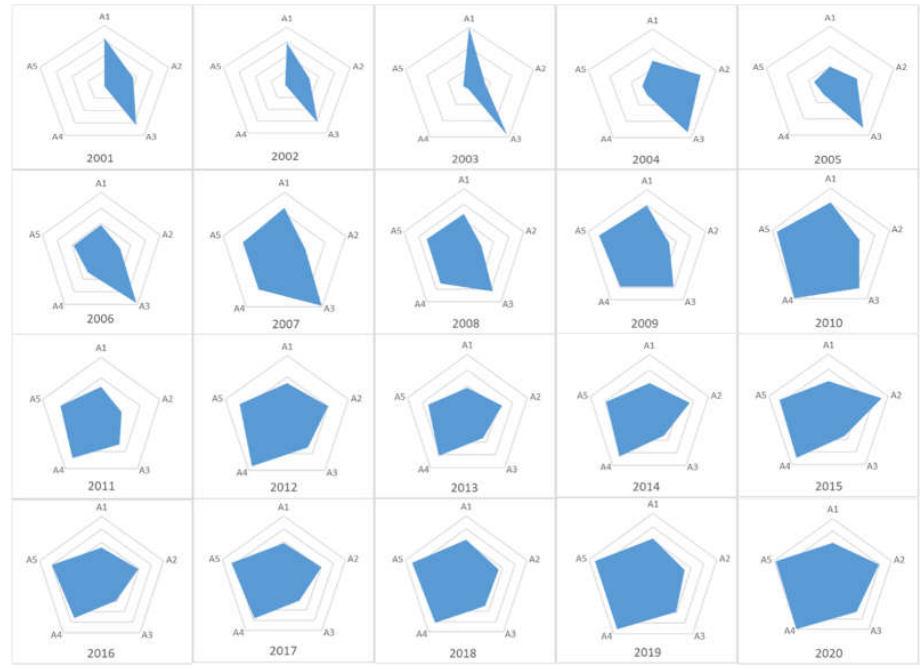
Figure 3. Chart of Changes in the Connotation of China’s Food Security from 2001 to 2020.